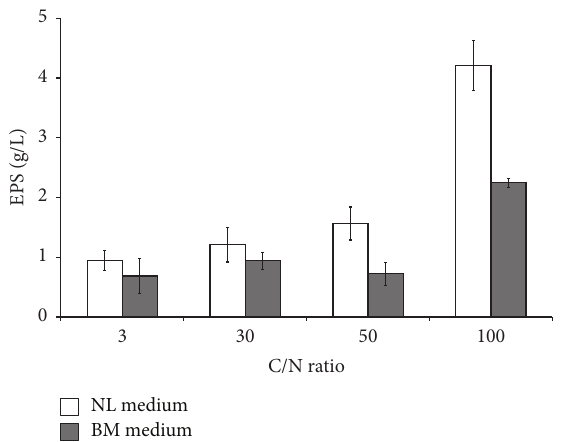
Figure 2: Effect of the C/N ratio and nutrient limitation on the EPS production by S. degradans from glucose as C source. The strain was cultured on the basal medium (BM) and on the nutrients limited medium (NL) which contains only 50% of N, P, S, Mg, Fe, and Ca regarding the BM.